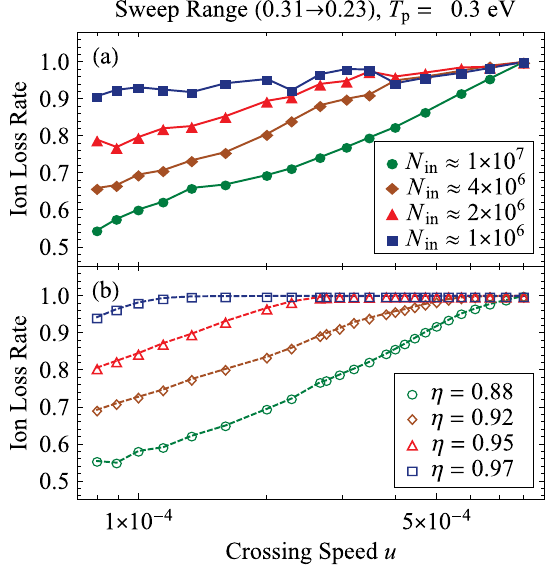
15. Comparison of measurement data with the corre- sponding ion-loss simulations. Experimental results of the quarter-integer resonance crossing with various initial ion numbers are plotted in the upper panel (a) as a function of the crossing speed u . The tune-sweep range is the same as in Fig. 11(b); namely, from 0.31 to 0.23. The corresponding WARP simulations assuming the initial plasma temperature of 0.3 eV are shown in the lower panel (b).